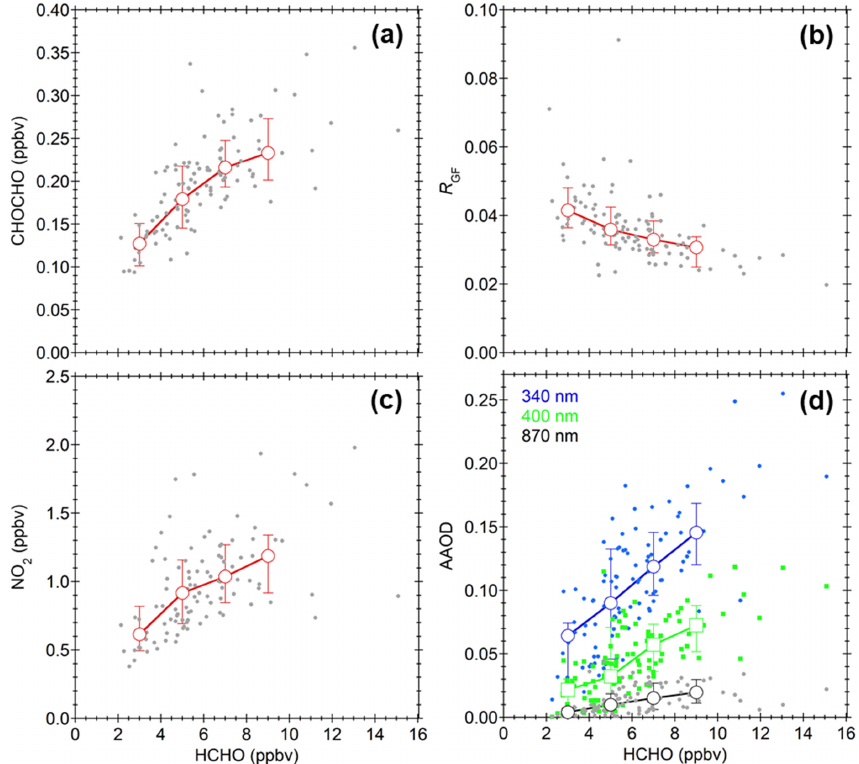
Figure 2. (a) CHOCHO concentration, (b) R GF , (c) NO 2 concentration, and (d) AAOD values plotted as a function of HCHO concentration. AAOD values at 340, 400, and 870nm are shown in blue, green, and black, respectively. The medians of respective quantities for each 2ppbv bin of HCHO concentration are shown by open symbols. Error bars represent 67% ranges.